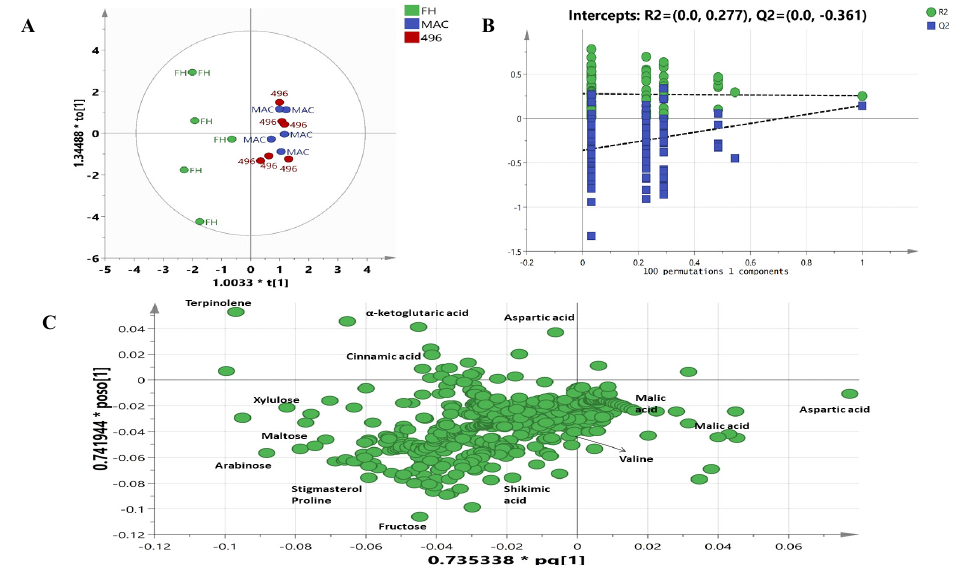
Figure 4 . ( A ) OPLSDA score plot of different cotton varieties; ( B ) validation by 100 permutations; ( C ) loading scatter plot of OPLSDA .